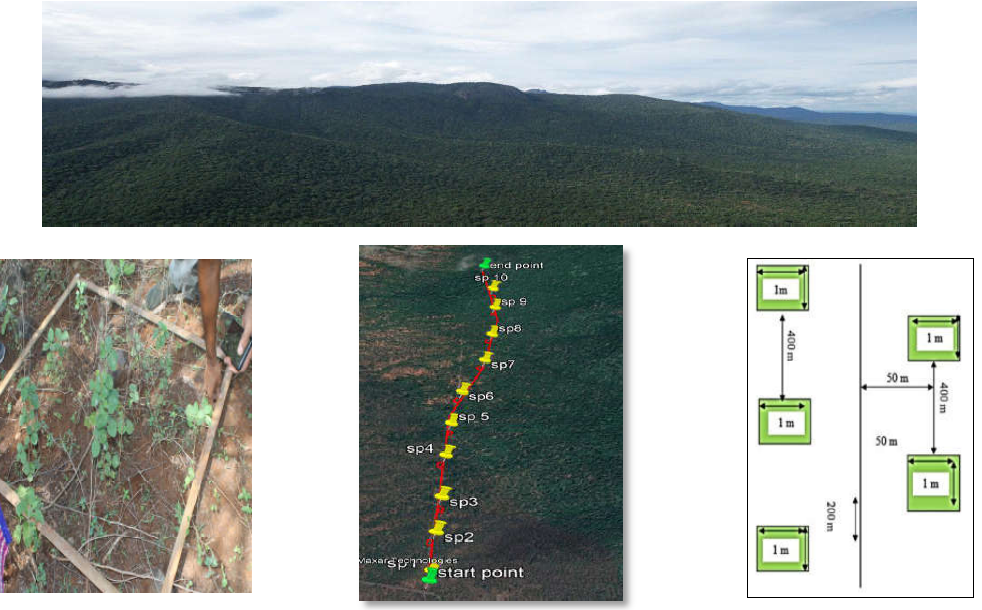
Figure 1. Map shows 1 × 1 m size of sample plots for grass fodder in the study area. (SP- Sample plot numbers).